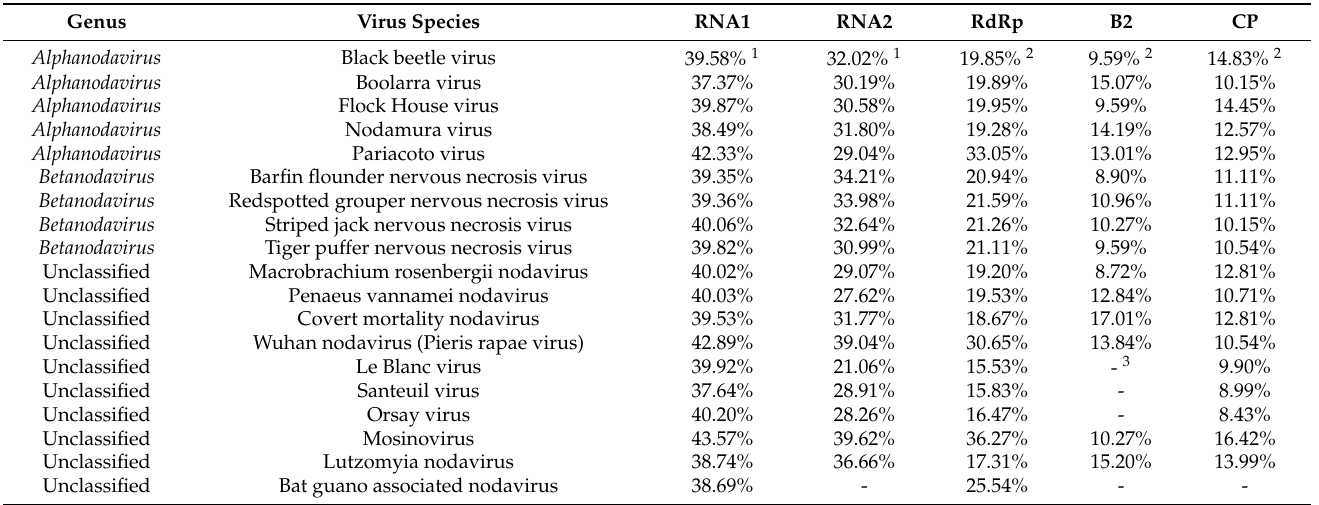
Table 3. Sequence homologies between RNLV1 genomic RNAs, proteins and that of other nodaviruses.